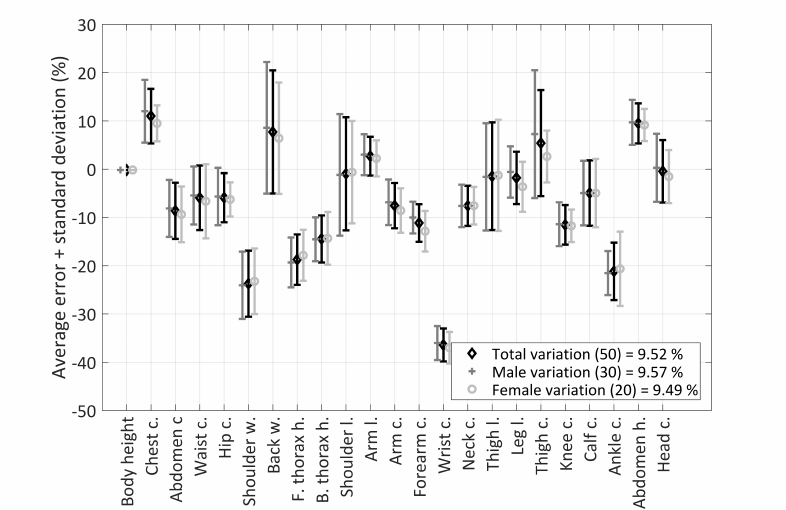
Figure 6. Czech children. Average variations and the standard